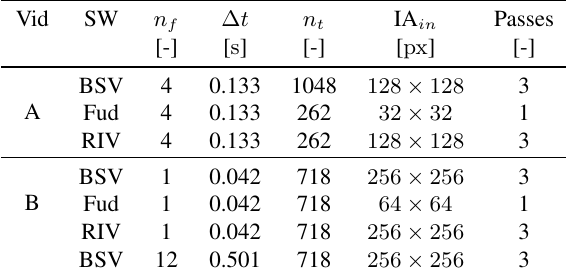
Table 2. PIV parameters used in BASESURV (BSV), Fudaa-LSPIV (Fud) and RIVeR (RIV). Column n f refers to the interval in terms of number of frames within every pair of images used for PIV; n t is number of instantaneous